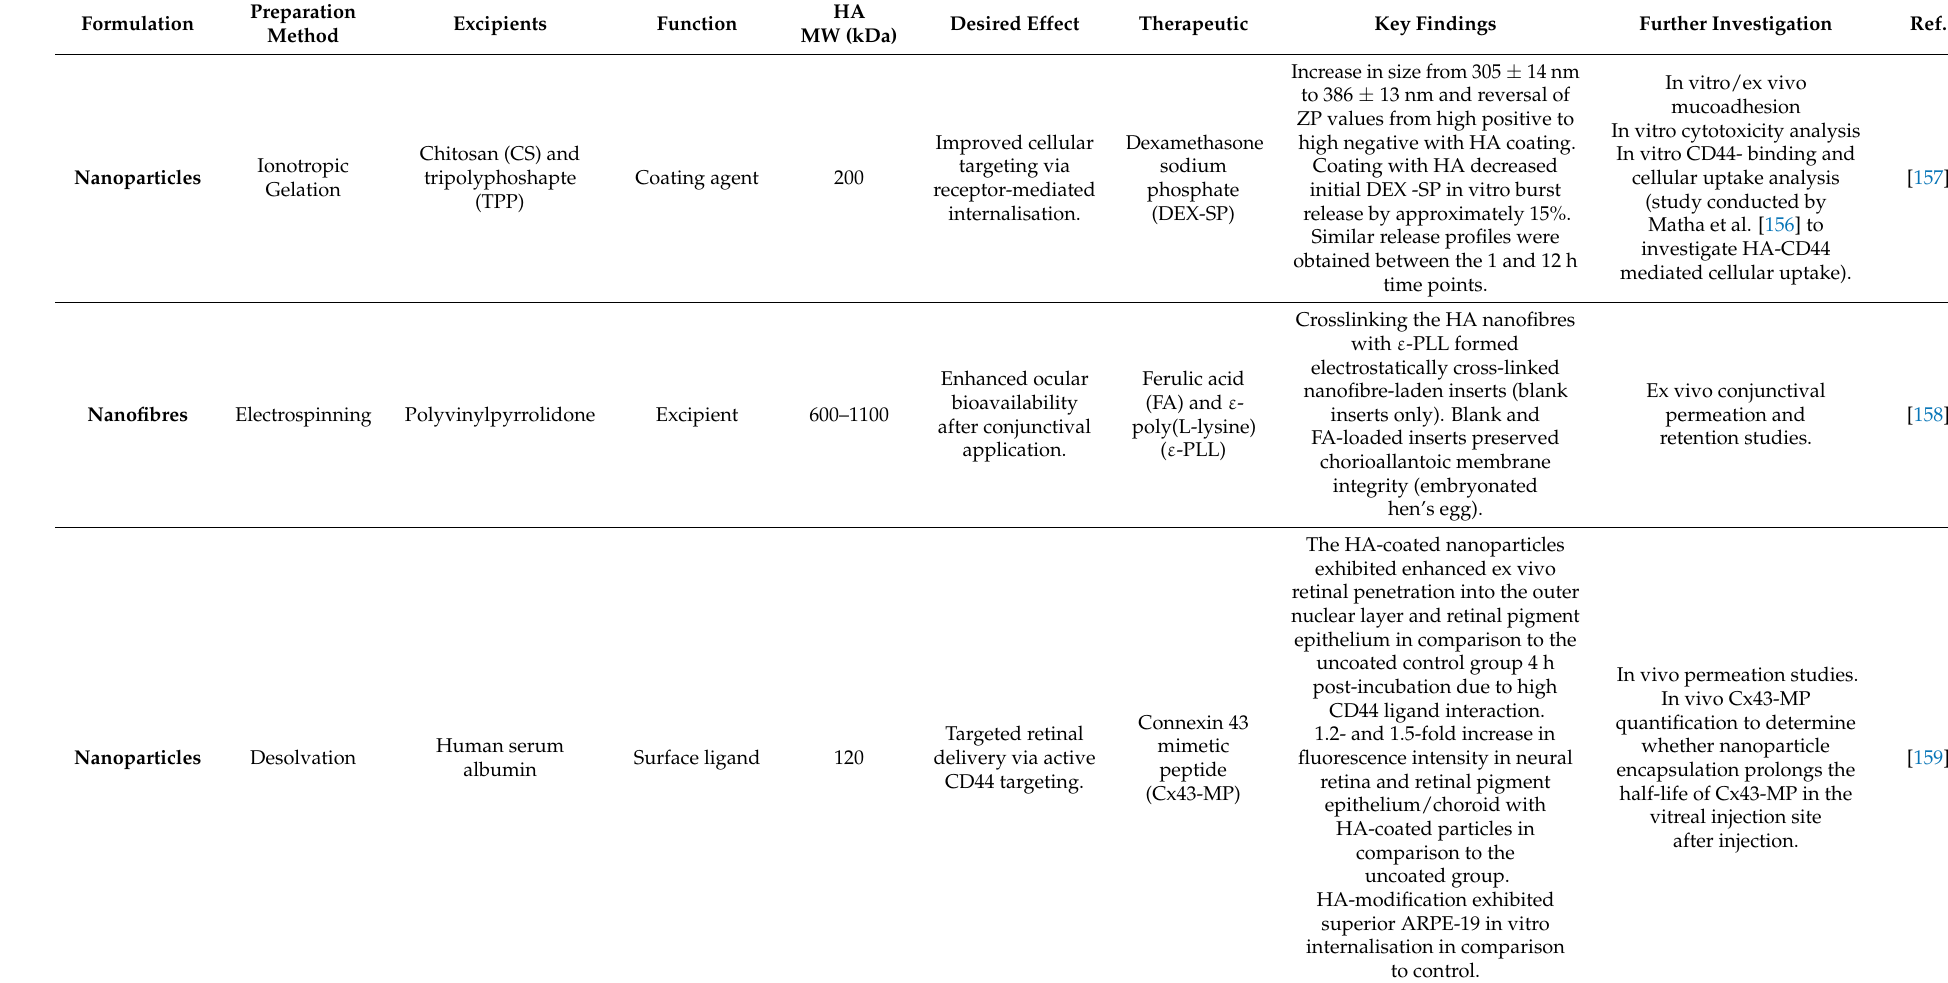
Table 2. A synopsis of HA-based nanoformulations in ocular drug